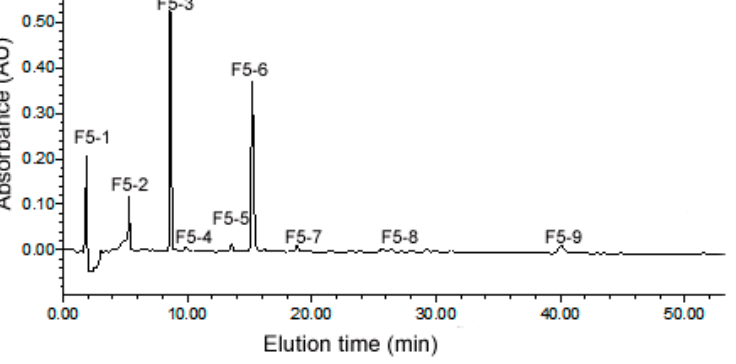
Figure 2. Purification profile of the fraction F5 by the reversed phase high performance liquid chromatography (RP-HPLC).